Question: Write a single sentence explaining what this figure depicts.
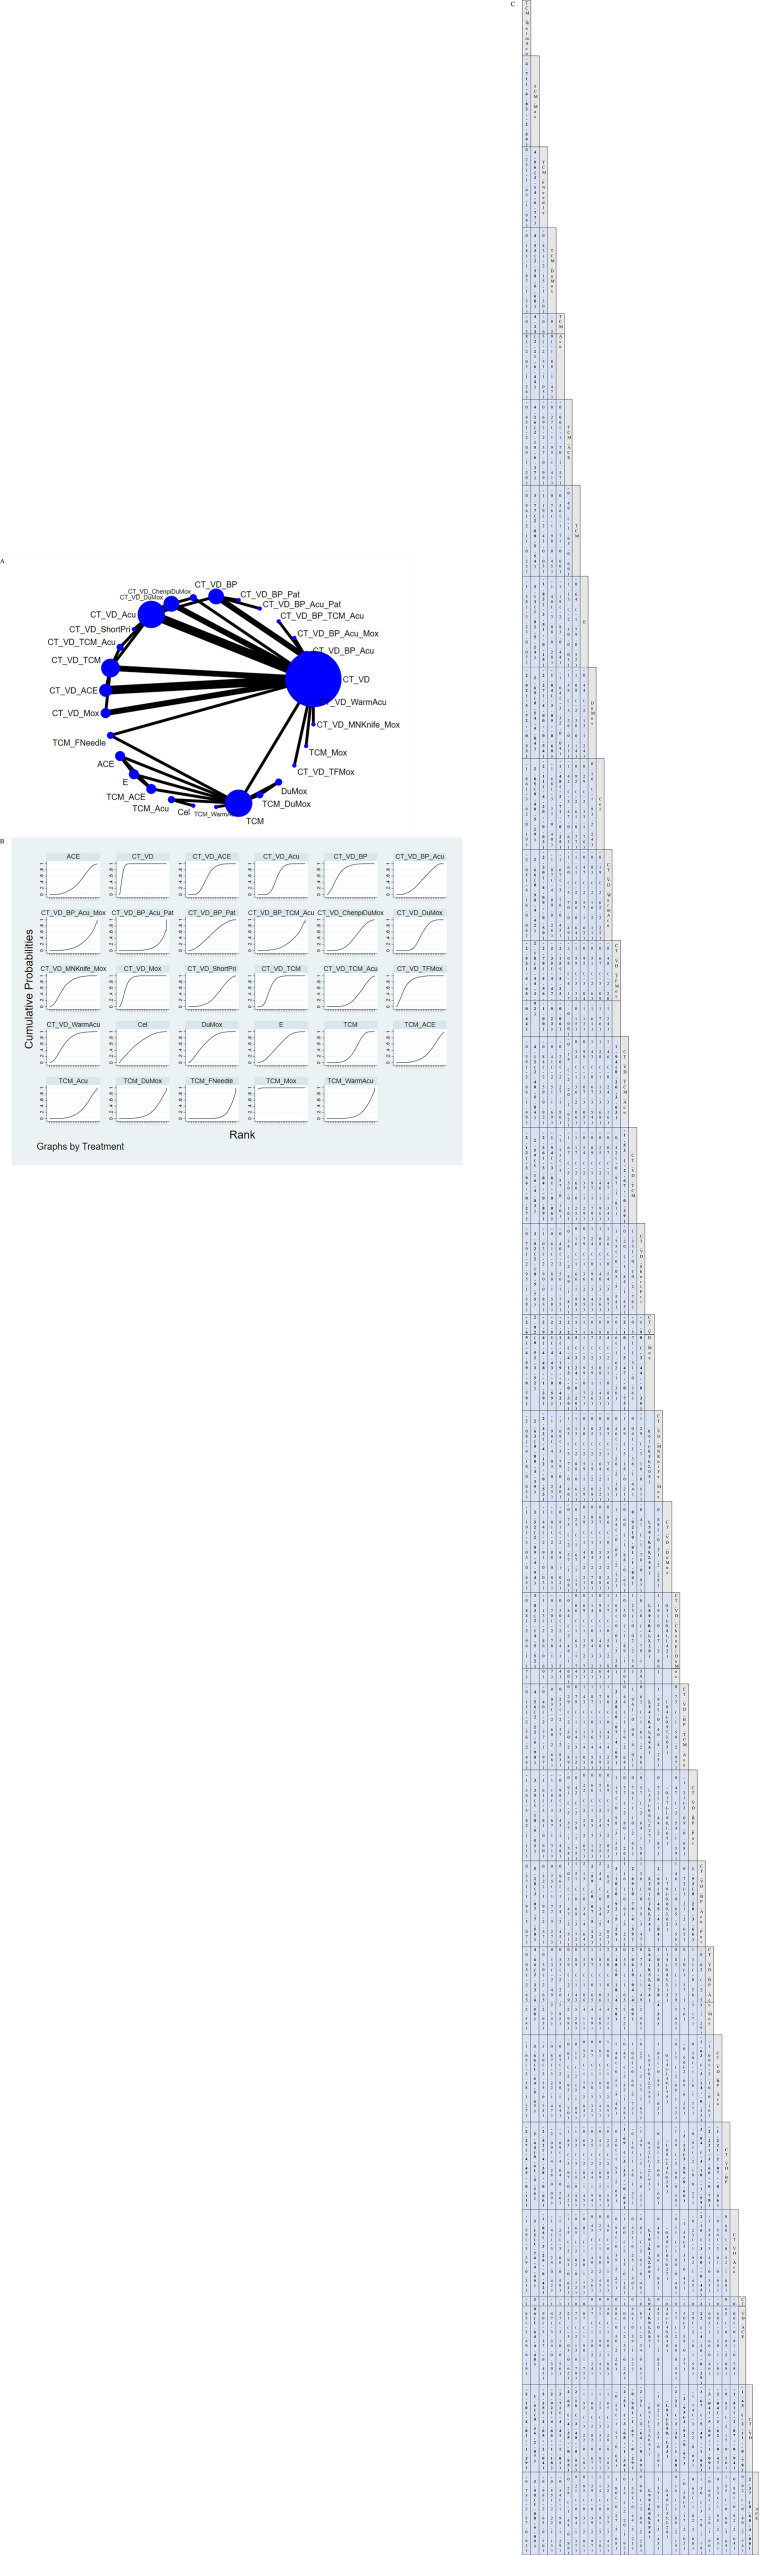
Answer: Network meta-analysis of the VAS score. (A) Network plot of the network meta-analysis for the VAS score. (B) Rankogram of overall intervention strategies from the network meta-analysis for the VAS score. (C) League table of the network meta-analysis for the VAS score.